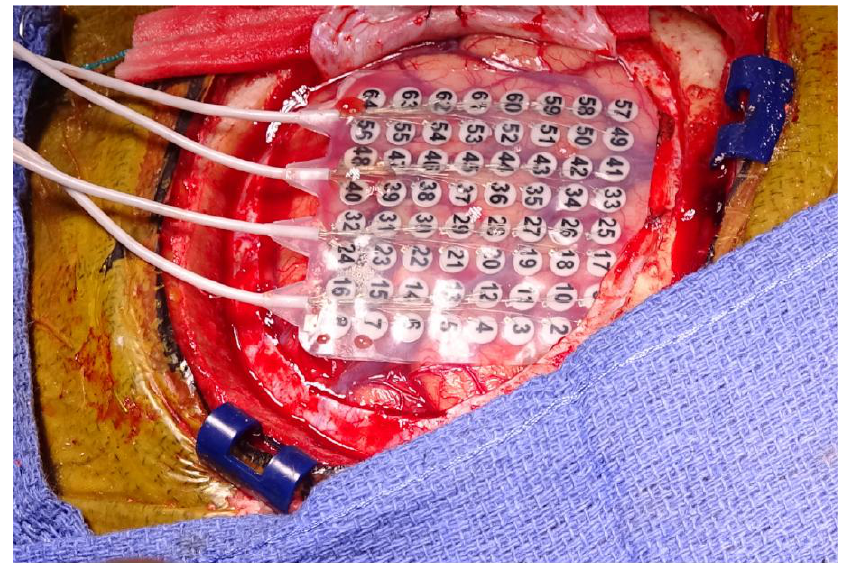
Figure 2. Awake craniotomy for cortical mapping and tumor resection. Electrode placement for monitoring and localization of eloquent areas. (Original image).